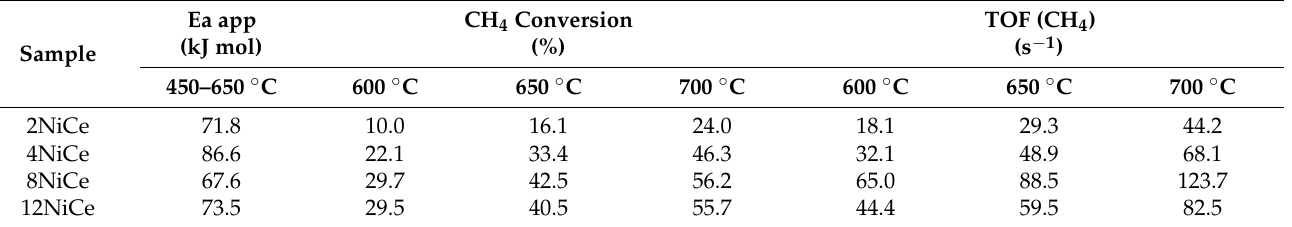
Table 6. Apparent activation energy, conversions, and the corresponding turnover frequency (TOF) values over xNiCe catalysts.